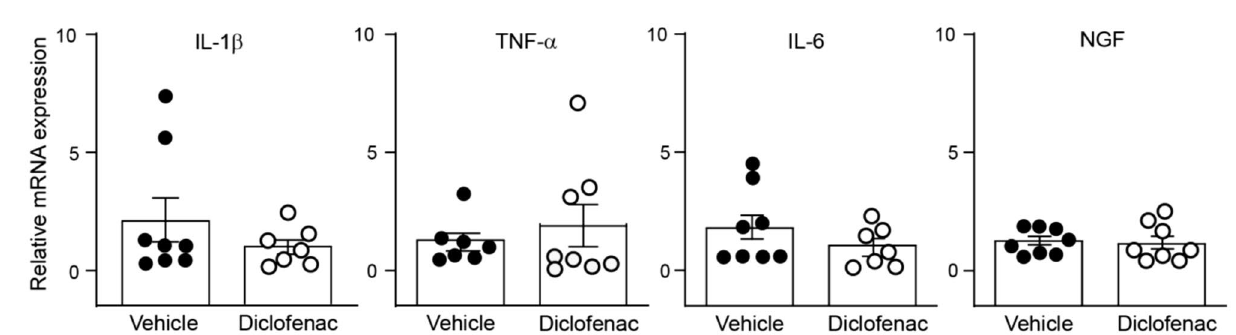
Figure 5. Expression of inflammatory mediator mRNAs in inflamed paw tissue. mRNA levels of IL-1β, IL-6, TNF-α and NGF after daily subcutaneous treatment with vehicle or diclofenac (DCF; 20 mg/kg) at 4 days after intraplantar complete Freund’s adjuvant inoculation. P > 0.05 versus vehicle, two-tailed unpaired t-test. Data represent relative mRNA expression levels normalized to GAPDH, are expressed as fold change versus vehicle, and are shown as means ± SEM and individual data points (n = 7–8 samples per